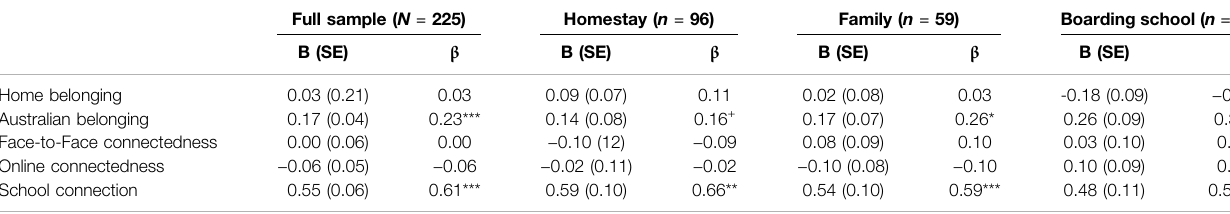
TABLE 3 | Unstandardized and standardized coef fi cients for predictors of social wellbeing.